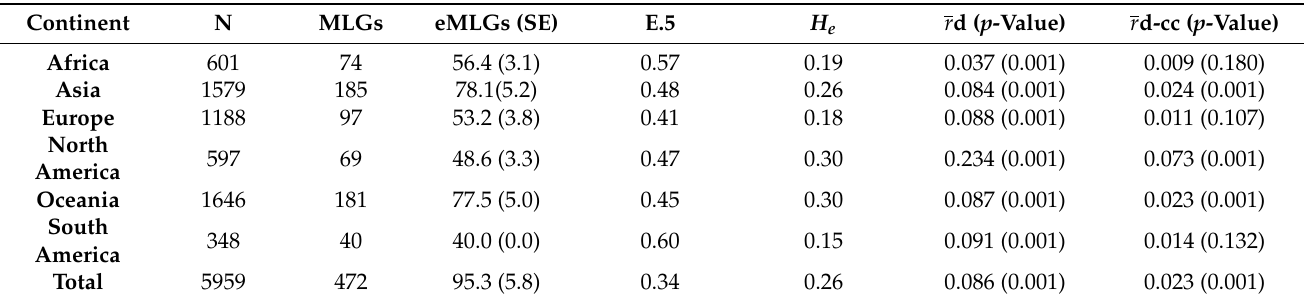
Table 2. Genetic diversity estimates for the 2020 SARS-CoV-2 study